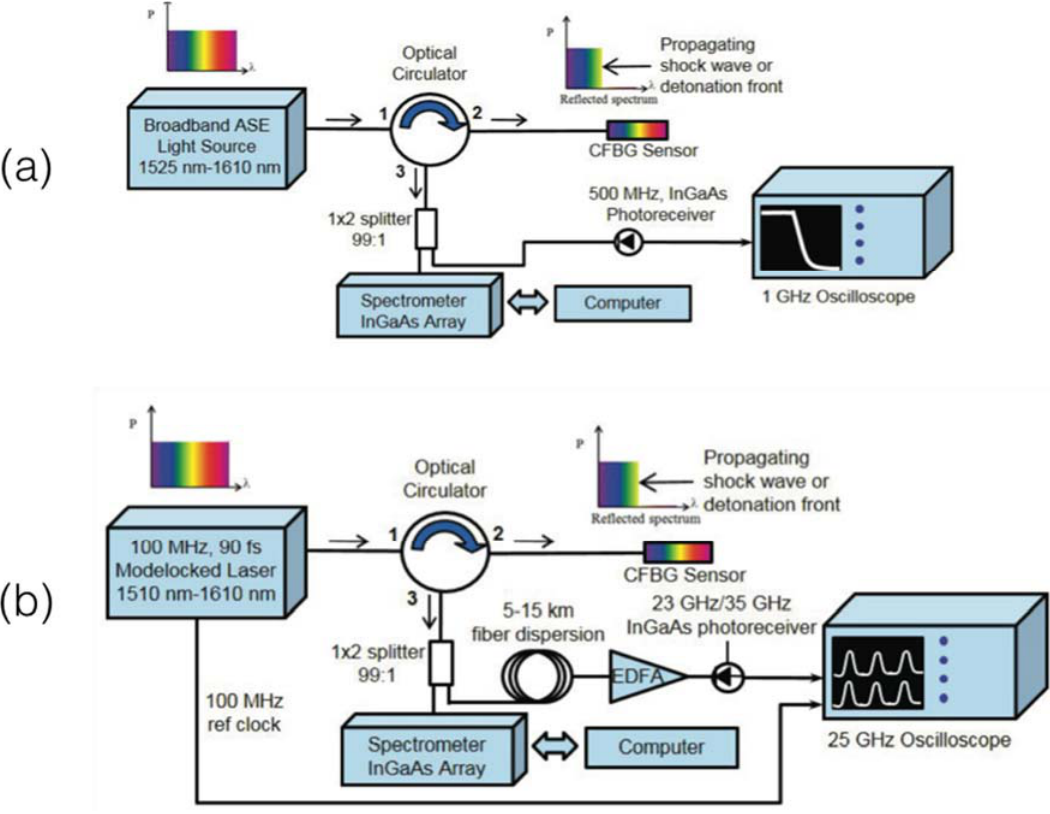
Figure 11. Schematic of high-speed CFBG interrogation systems proposed by Rodriguez and Gilbertson: ( a ) InGaAs photodetector-based setup; ( b ) fs laser-based scanning setup. Image adapted from [77].